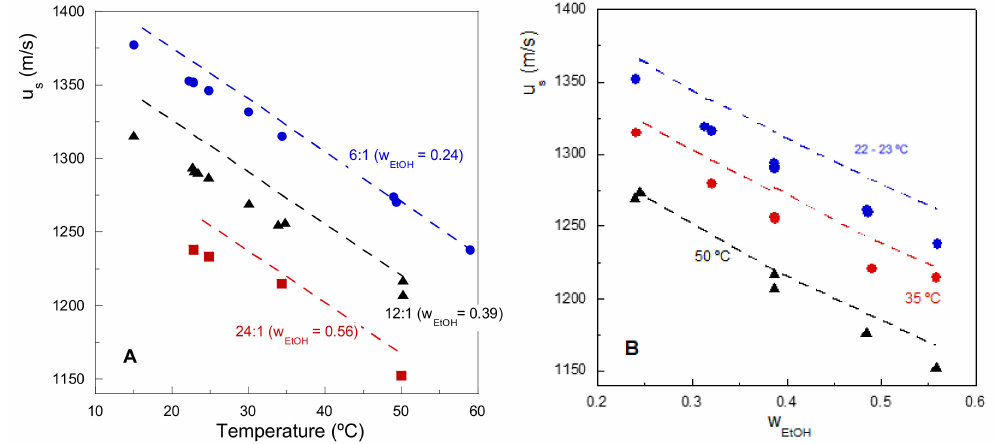
Figure 5. Initial speed of sound, experimental values (symbols), and the prediction made by Nomoto’s expression (lines) for ethanolysis reactions carried out at different alcohol molar ratios and tempera- tures. ( A ) Effect of the temperature reaction, ( B ) Effect of the alcohol